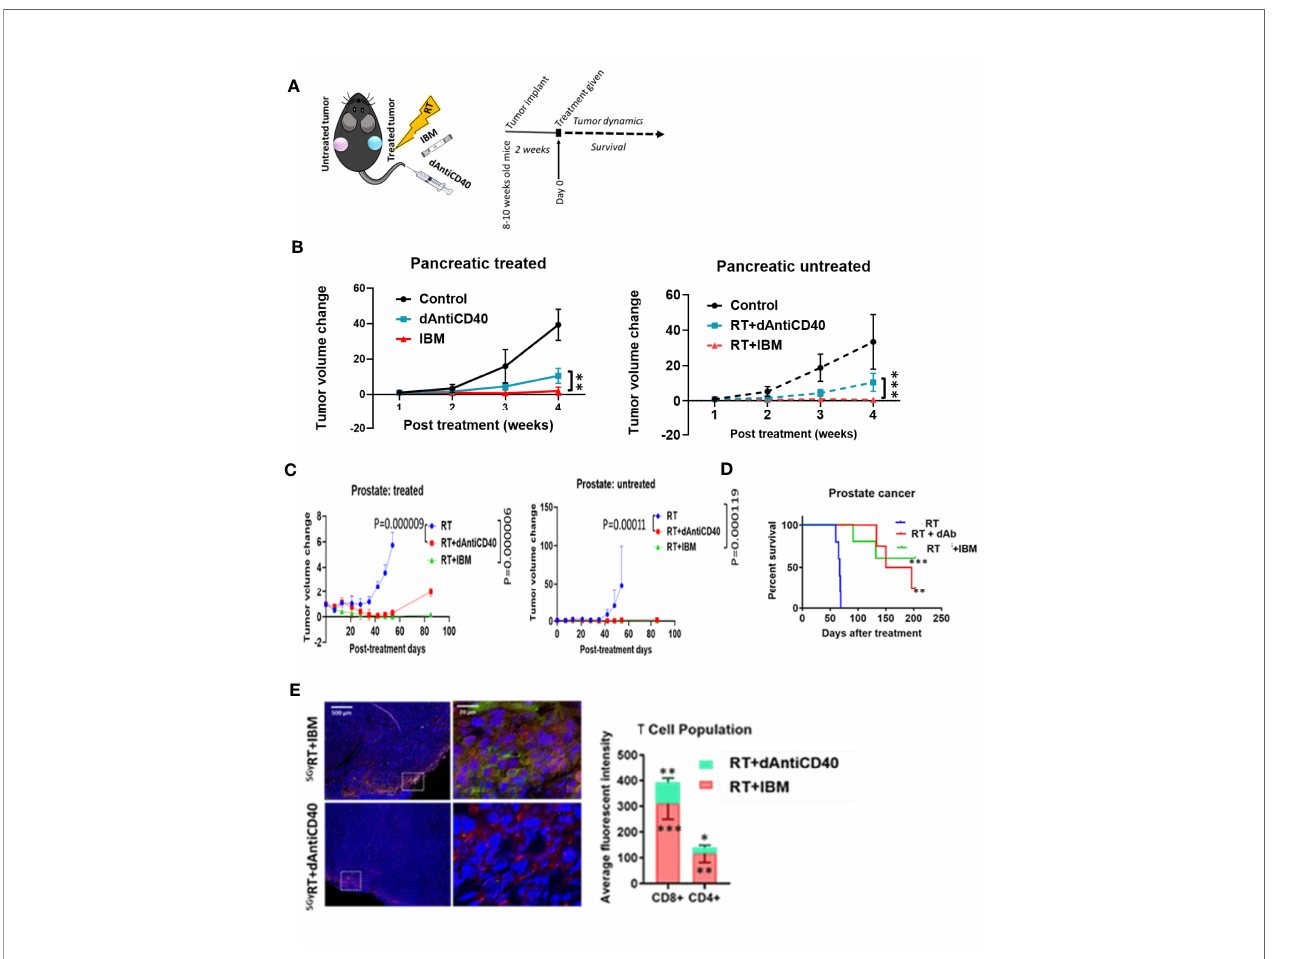
FIGURE 3 | IBM enhances higher abscopal effect when compared with direct intratumor injection of anti-CD40 agonist (dAntiCD40). (A) Study design. (B) Line graphs showing dynamics of tumor volume change of pancreatic cancer for both treated (solid line) and the other untreated cancer (dashed line, in situ vaccination effect) where IGRT of 5 Gy was given either as direct intratumoral injection of anti-CD40 (dAntiCD40) or IBM along with 5 Gy of radiation. (C) In prostate cancer model, line graphs showing dynamics of tumor volume change in prostate cancers of both treated (left) and the other untreated/metastatic cancer (right in situ vaccination effect) where image-guided radiotherapy (IGRT) at 5 Gy was administered either in combination with direct intratumoral injection of anti-CD40 (dAntiCD40) or IBM. (D) Corresponding Kaplan-Meier survival graph. (E) Representative images and bar graph showing IF staining of untreated pancreatic cancer tissue stained with CD4 + and CD8 + antimouse antibody, showing intratumoral in fi ltration of CD4 + (green) and CD8 + (red) T lymphocytes, comparing the abscopal effect of tumors treated with RT+dAntiCD40 ( n = 3) and RT+IBM ( n = 3). In all cases, nucleus is stained with DAPI (blue). Scale bar represents 200 µm. The corresponding bar graph showing average fl uorescence intensity of in fi ltrating helper CD4 + and cytotoxic CD8 + T lymphocytes in untreated tumor tissue on the opposite fl ank (abscopal tumors) 14 days following the treatment. Data represent the mean ± SD. * p < 0.5, ** p < 0.01, *** p <